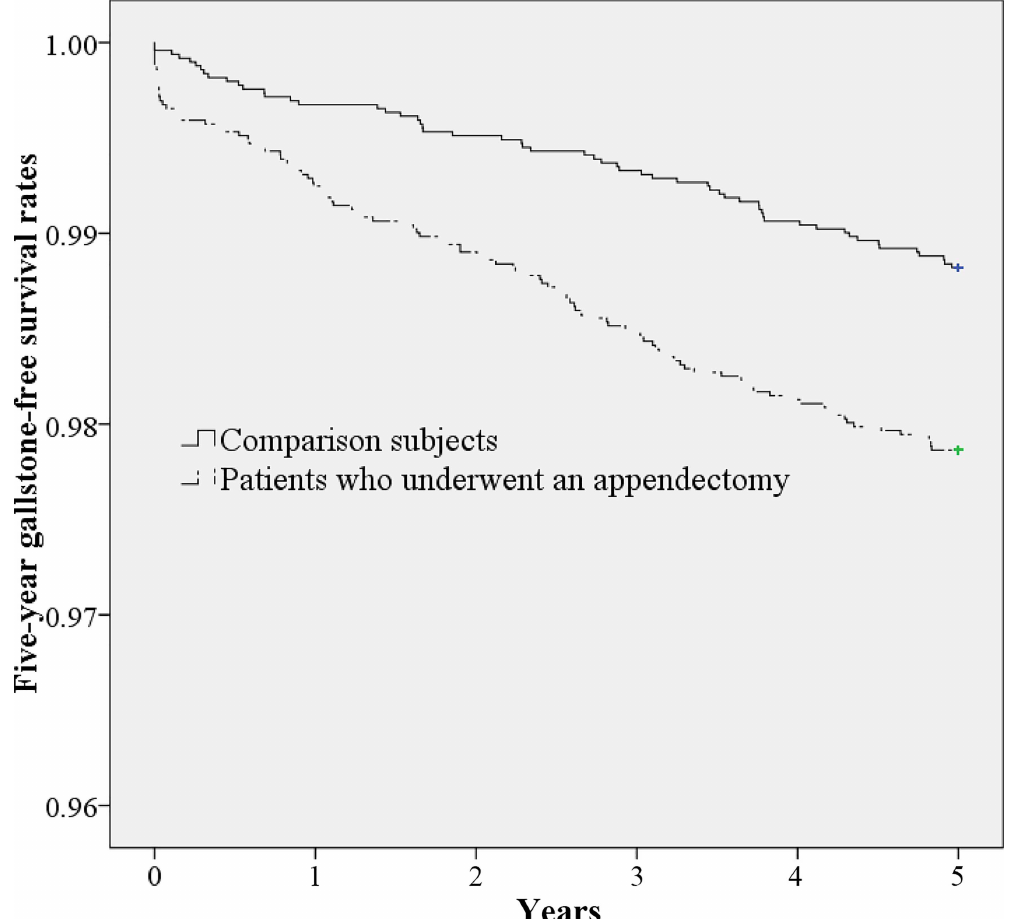
Fig 1. Five-year gallstone-free survival rates for those who underwent an appendectomy and comparison subjects.